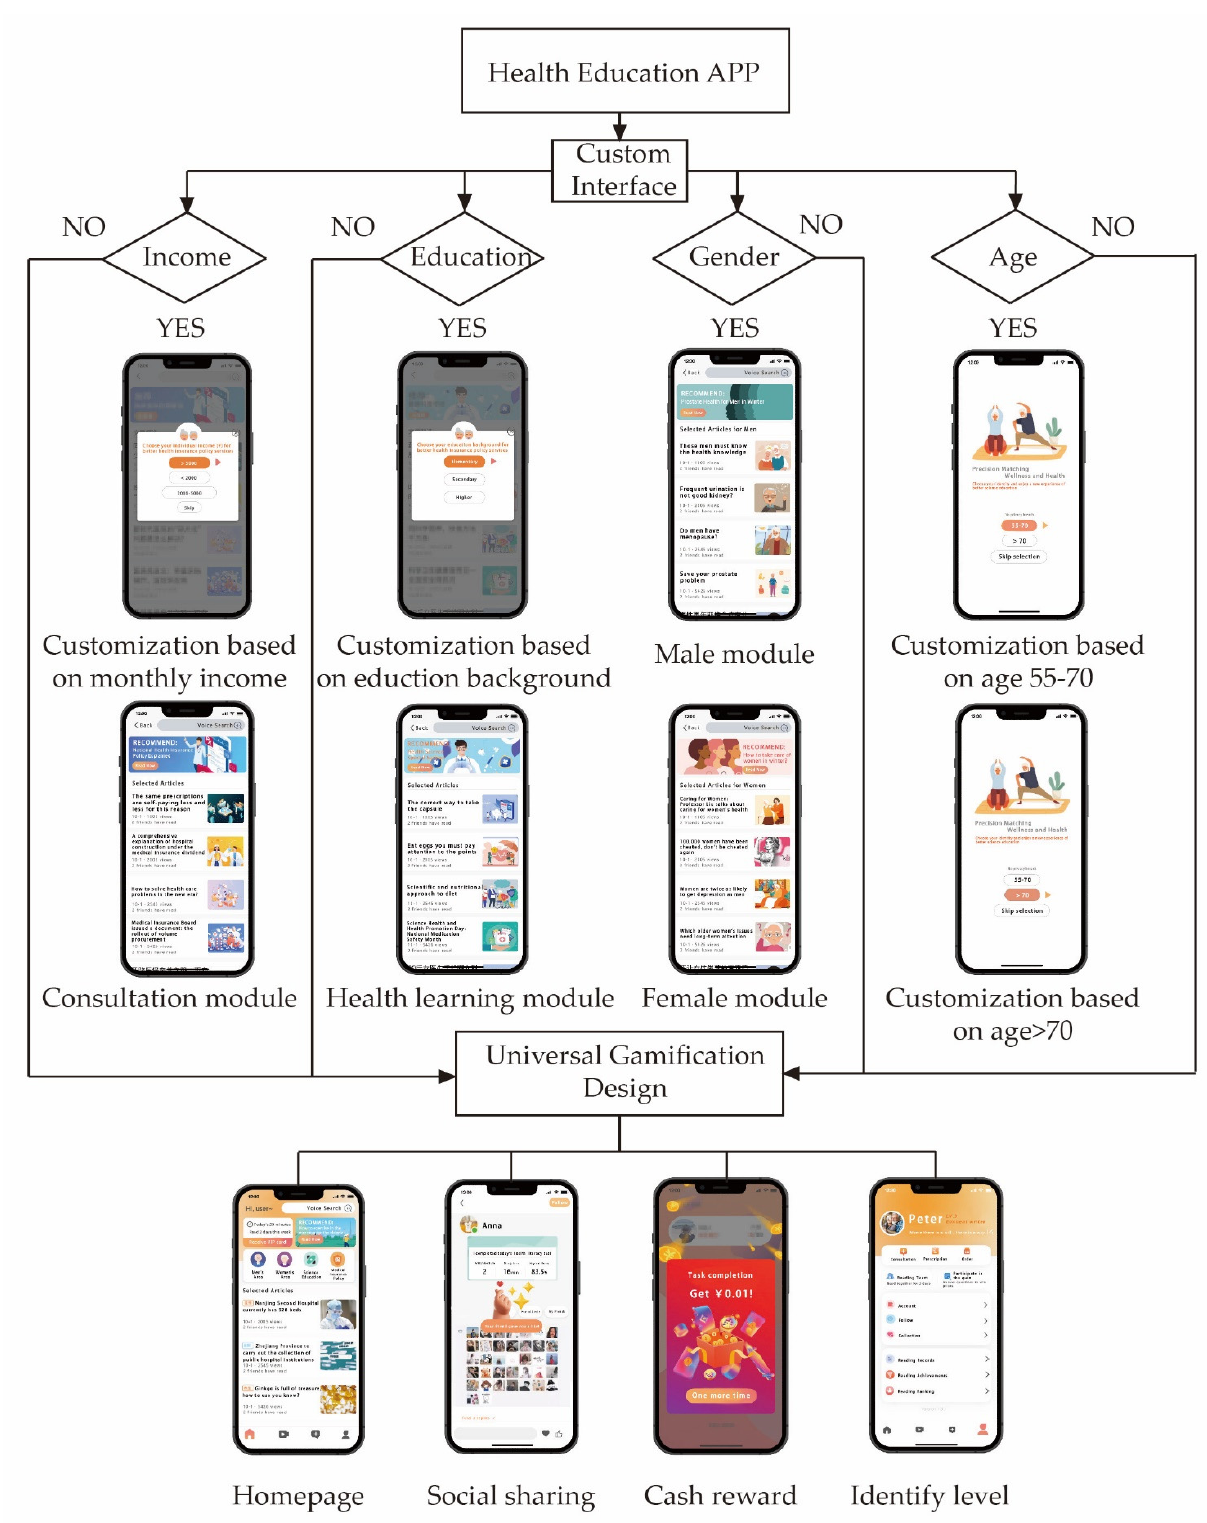
Figure 6. Information architecture of health education app design for the